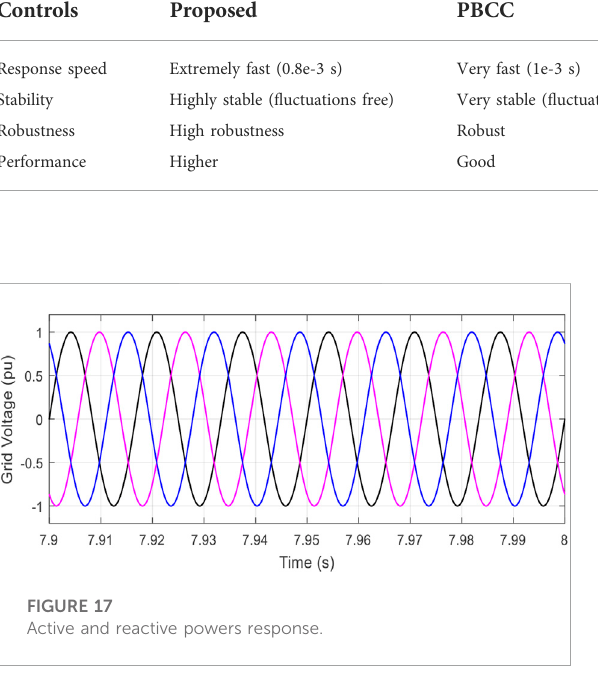
FIGURE 17 Active and reactive powers